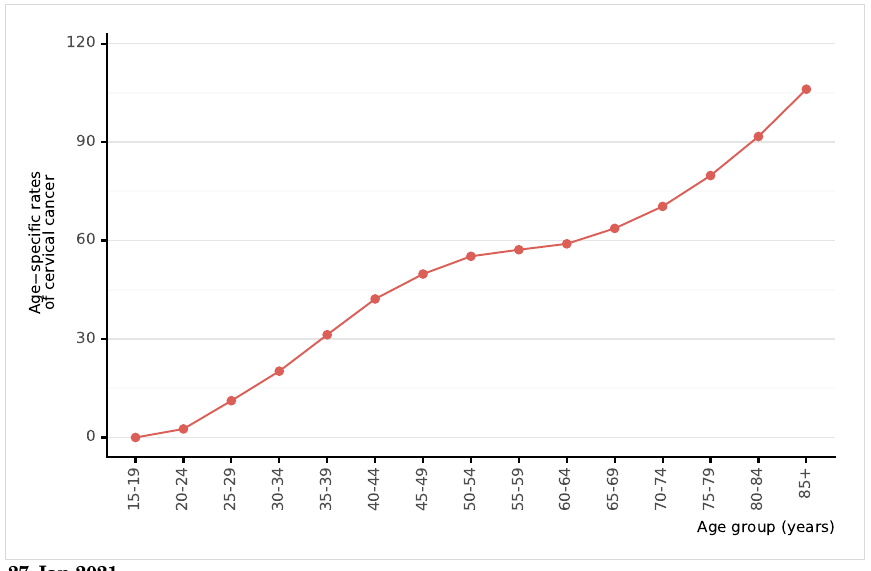
Figure 8: Age-specific incidence rates of cervical cancer in Peru (estimates for 2020)